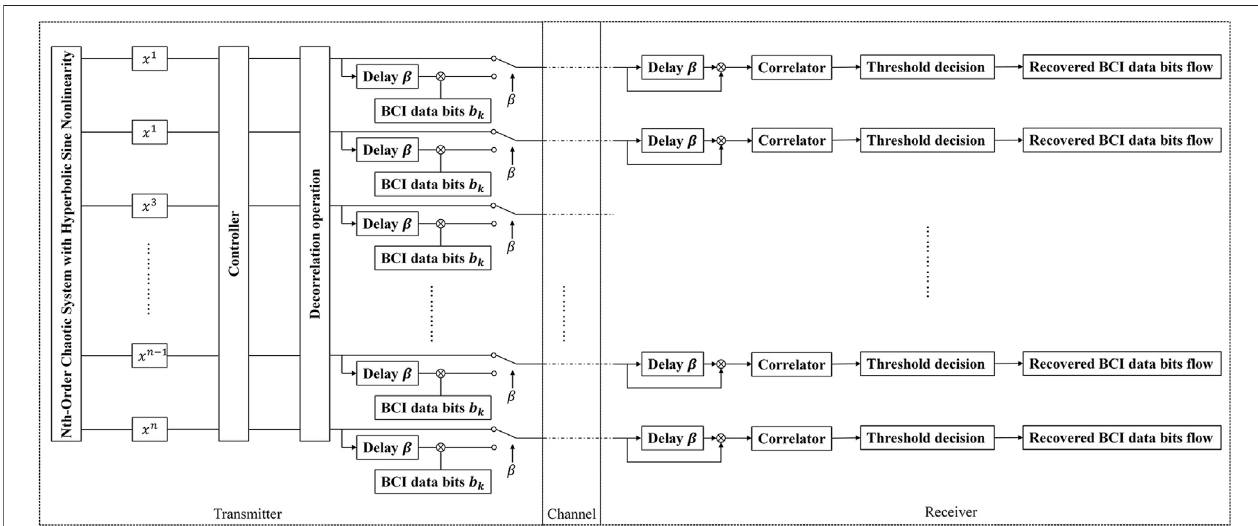
Frontiers in Physics |